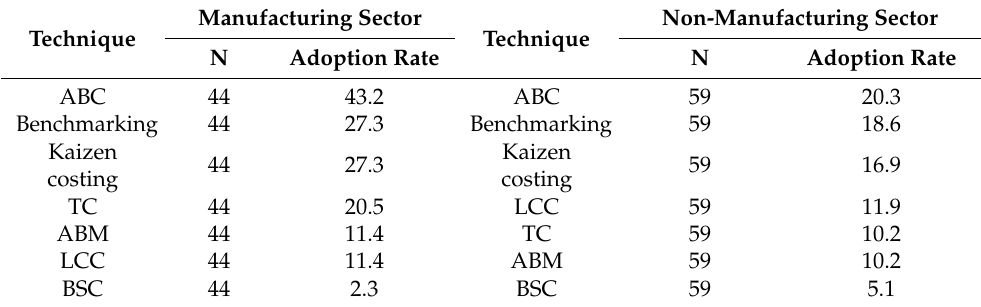
Table 19. The adoption rate of